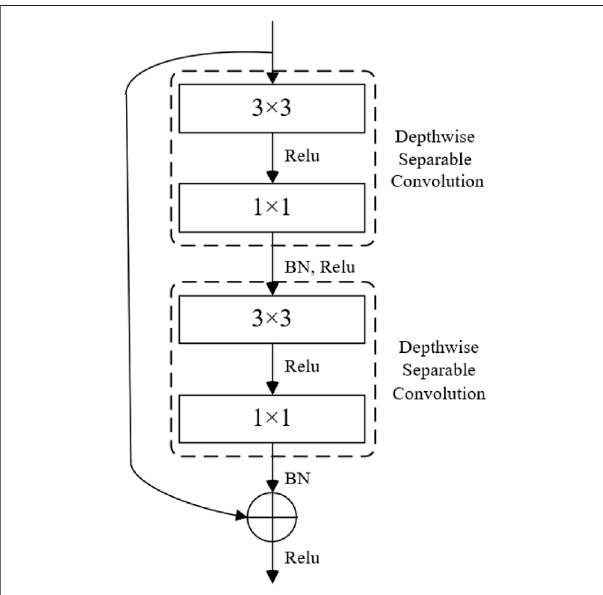
FIGURE 6 | The depthwise separable residual module structure.